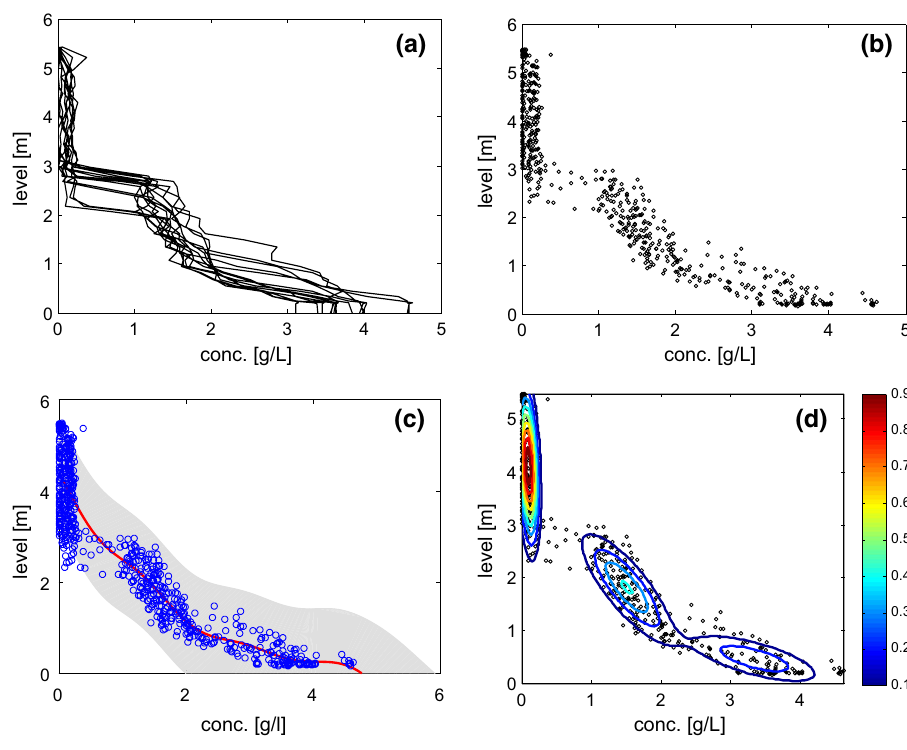
Fig. 2 a Sludge profiles used as training data set; b sludge profiles in a plotted using dots; c predictive distribution over the training data set, showing 𝜇 ∗ 2 𝜎 (red line) and ± ∗ (grey zone); d contour of the GMM prob- ability density function, with values indicated with colour